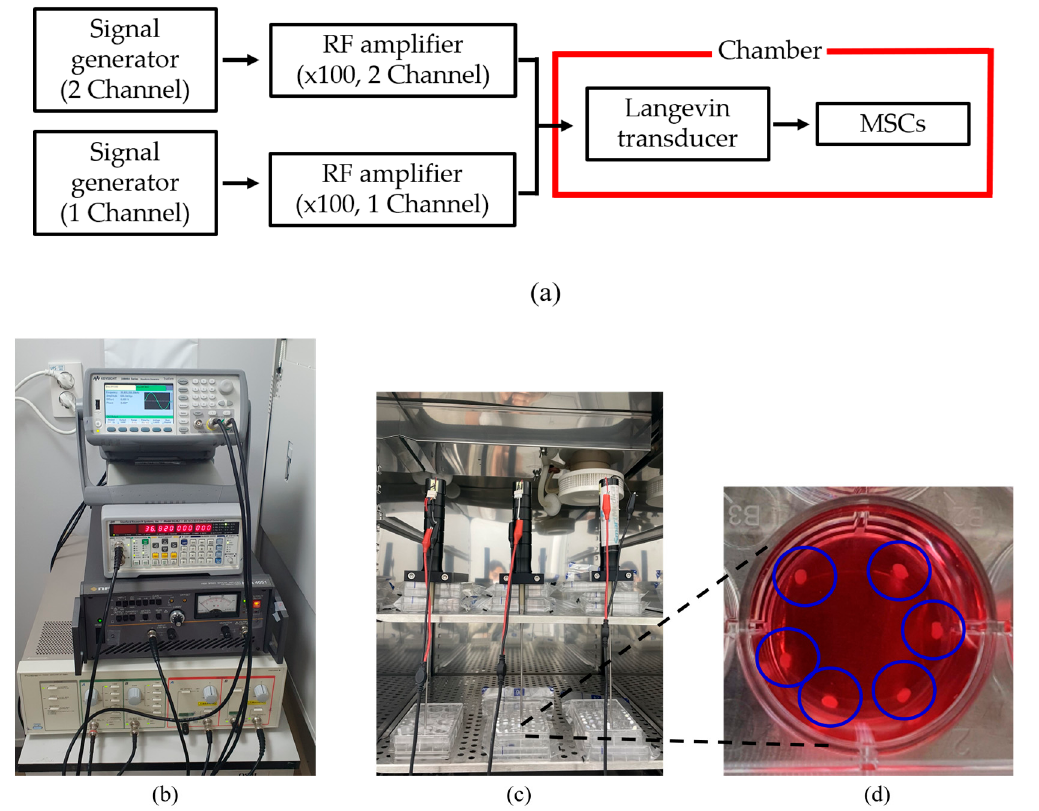
Figure 4. Configuration for ultrasound test: ( a ) flow chart of equipment operation, ( b ) system for transducer excitation, ( c ) test chamber, ( d ) enlarged view of liquid badge and MSCs inside blue circles.